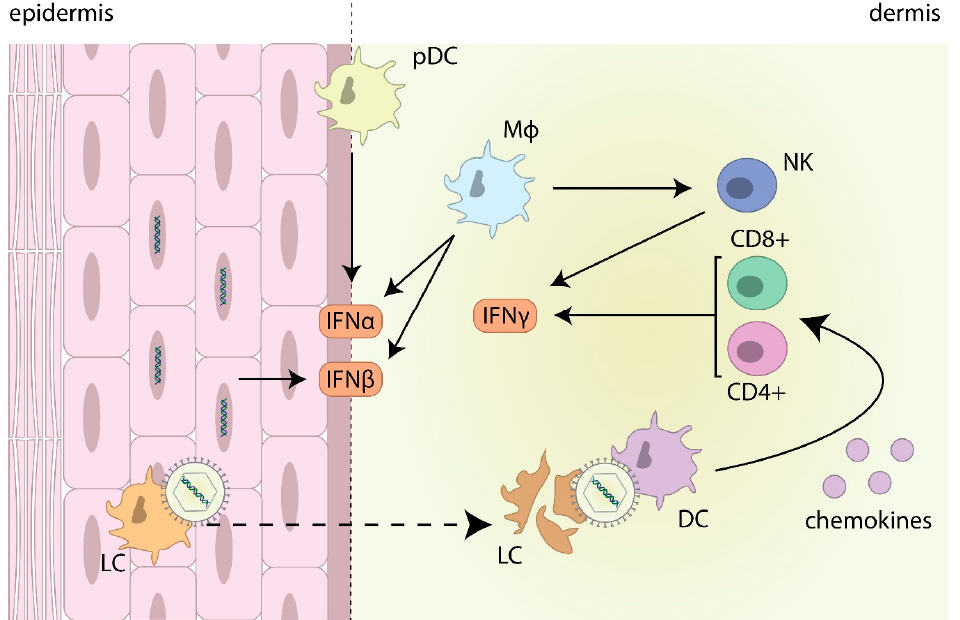
Figure 2. Interferon production in herpes lesions. HSV-1 infected keratinocytes secrete IFN β , and infiltrating plasmacytoid dendritic cells (pDCs) secrete primarily IFN α . Infiltrating macrophages (M φ ) contribute to IFN α and IFN β production, as well as secreting IL12, to activate natural killer (NK) cells to secrete IFN γ . HSV-1 infected Langerhans cells (LCs) migrate to the dermis where they undergo apoptosis, and HSV-1 antigens are taken up by dermal dendritic cells (DCs) to attract CD4 + and CD8 + T cells which also secrete IFN γ